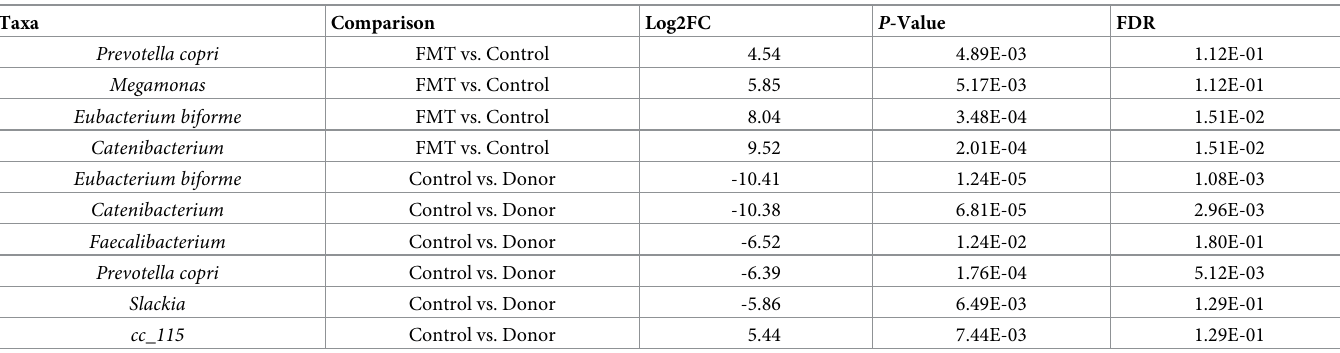
Table 5. Significant changes in taxa at 30 days.